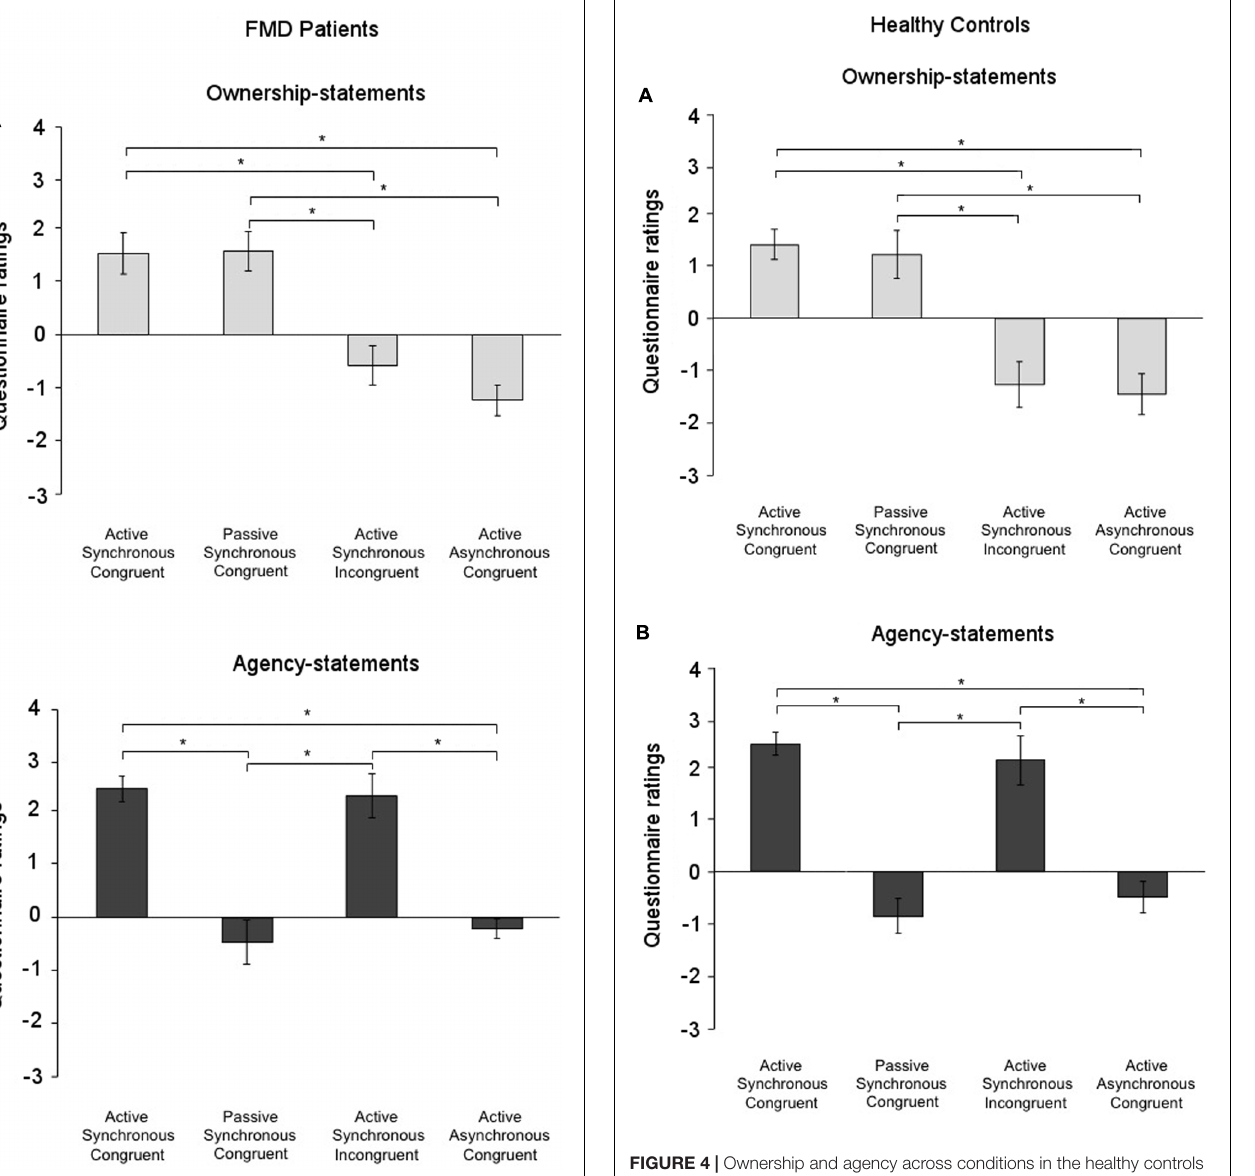
conditions ( − 1.27 ± 0.38) (all comparisons, p < 0.001) ( Figure 4A ). Agency-statement scores were higher in the Active Synchronous Congruent (2.42 ± 0.22) and the Active Synchronous Incongruent (2.11 ± 0.30) conditions than in the Active Asynchronous Congruent ( − 0.49 ± 0.34) and the Passive Synchronous Congruent conditions ( − 0.84 ± 0.46) (all comparisons, p < 0.001) ( Figure 4B ).